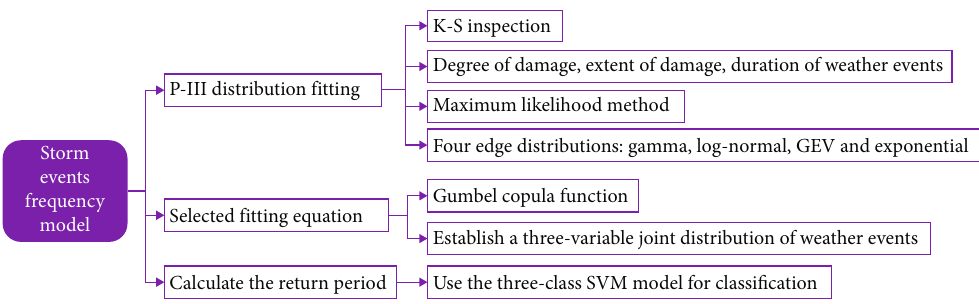
Figure 1: The idea of the storm event frequency